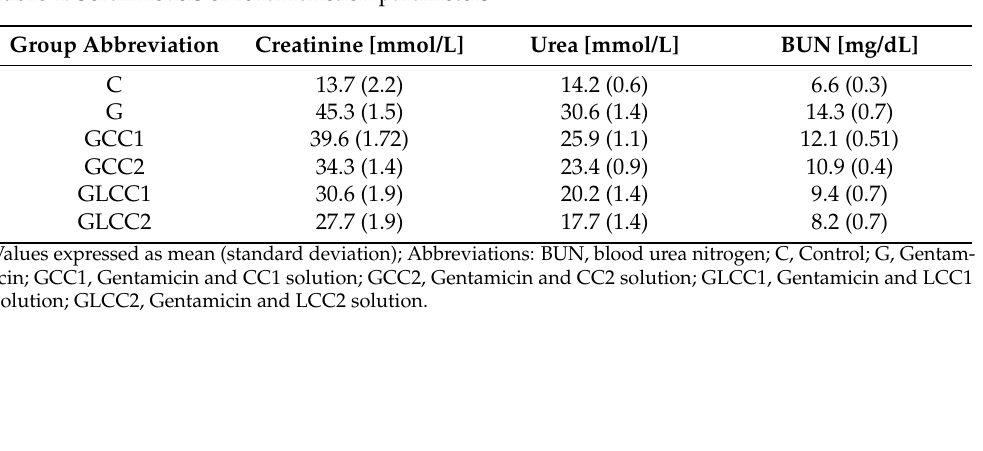
Figure 4. Variation by groups of matrix metalloproteinases: ( a ) MMP-2 (matrix metalloproteinases 2) ( b ) MMP-9 (matrix metalloproteinases 9) by groups. Notes: The circles represent the individual values, and the horizontal line is given by the median. Abbreviations: C, Control; G, Gentamicin; GCC1, Gentamicin and CC1 solution; GCC2, Gentamicin and CC2 solution; GLCC1, Gentamicin and LCC1 solution; GLCC2, Gentamicin and LCC2 solution; The letter codes correspond to